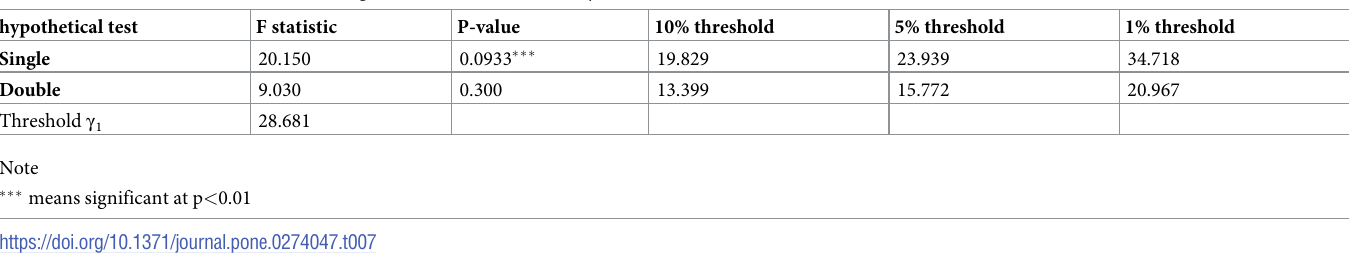
Table 7. Test results of threshold effect of agricultural insurance